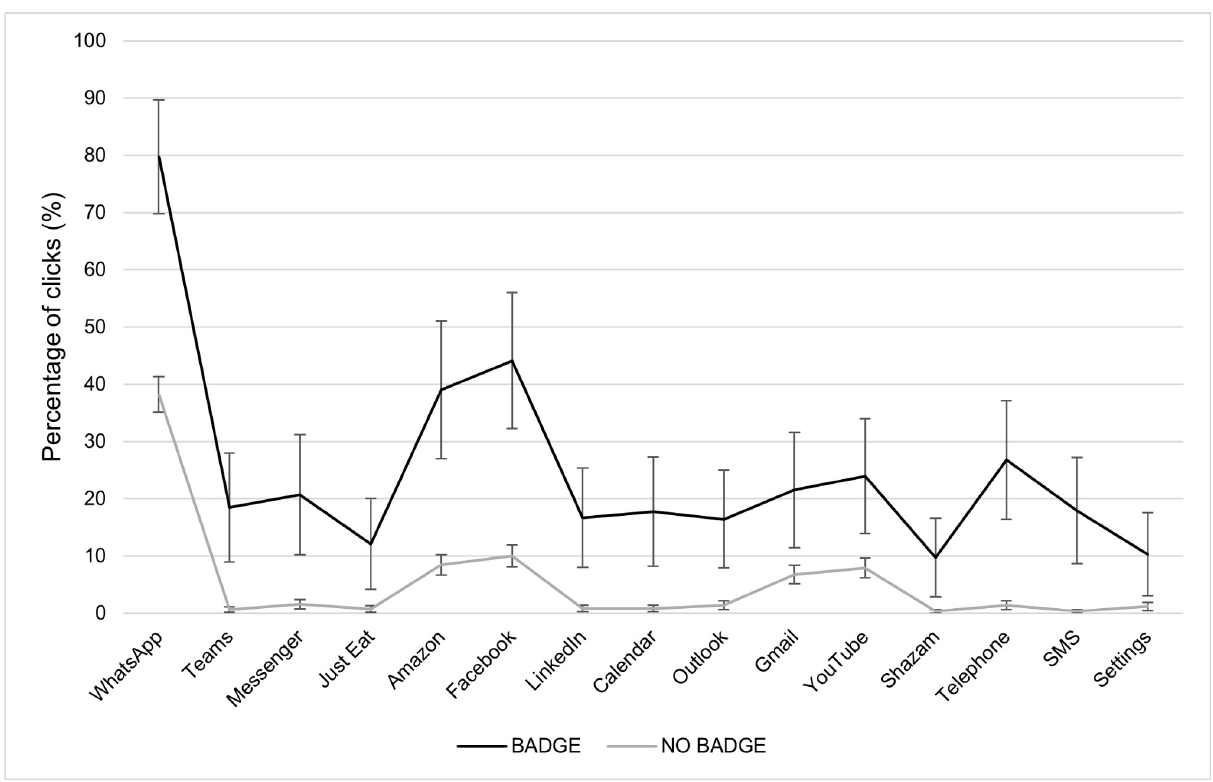
Fig 2. Percentage of clicks for each of the apps and experimental conditions (badge vs. no badge) with relative confidence intervals.